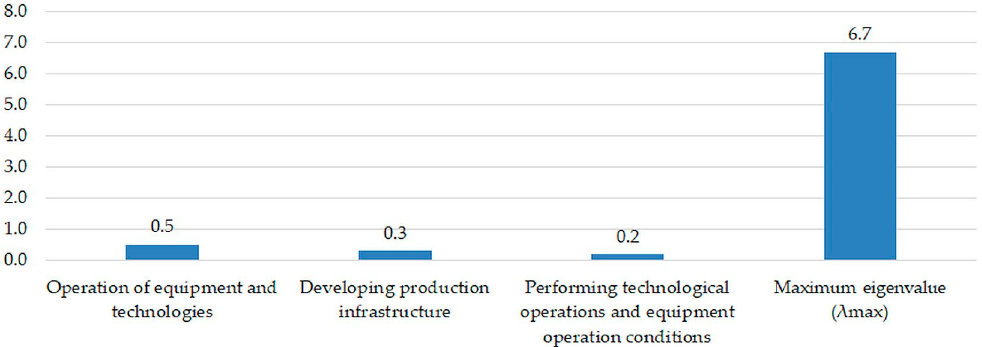
Figure 5. The degree of influence of the “Assessing resource saving and consumption in the production process” block at the “Factors” level.